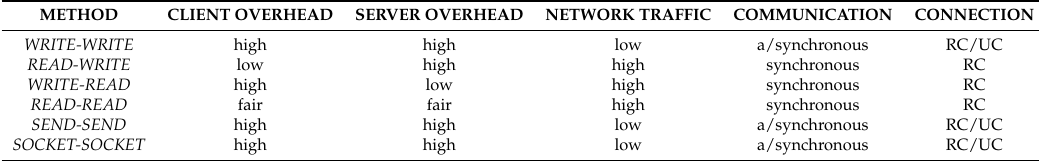
Table 1. Comparing communication